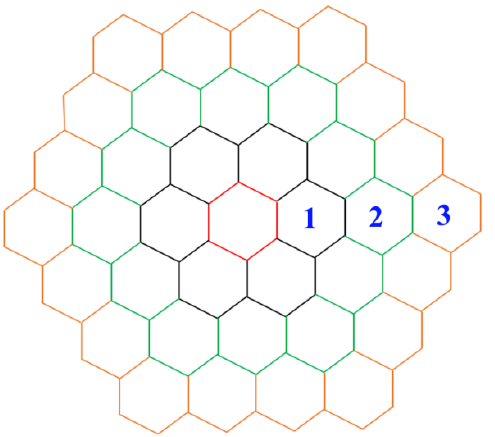
Figure 7. View of the measured points and their neighbors. The red polygon indicates the measured point; the black, green, and yellow polygons represent the first, second, and third adjacent points, respectively.